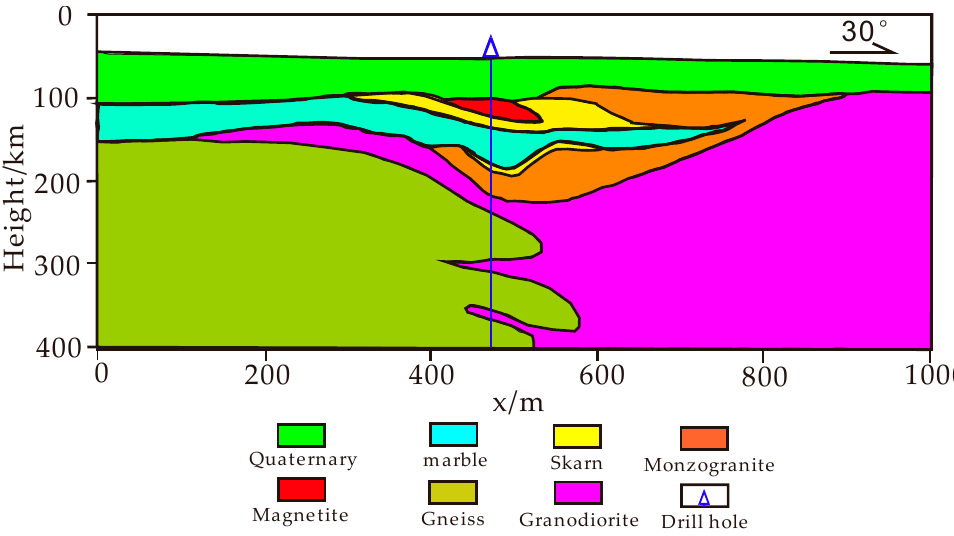
Figure 16. The underground distribution of line L [64].